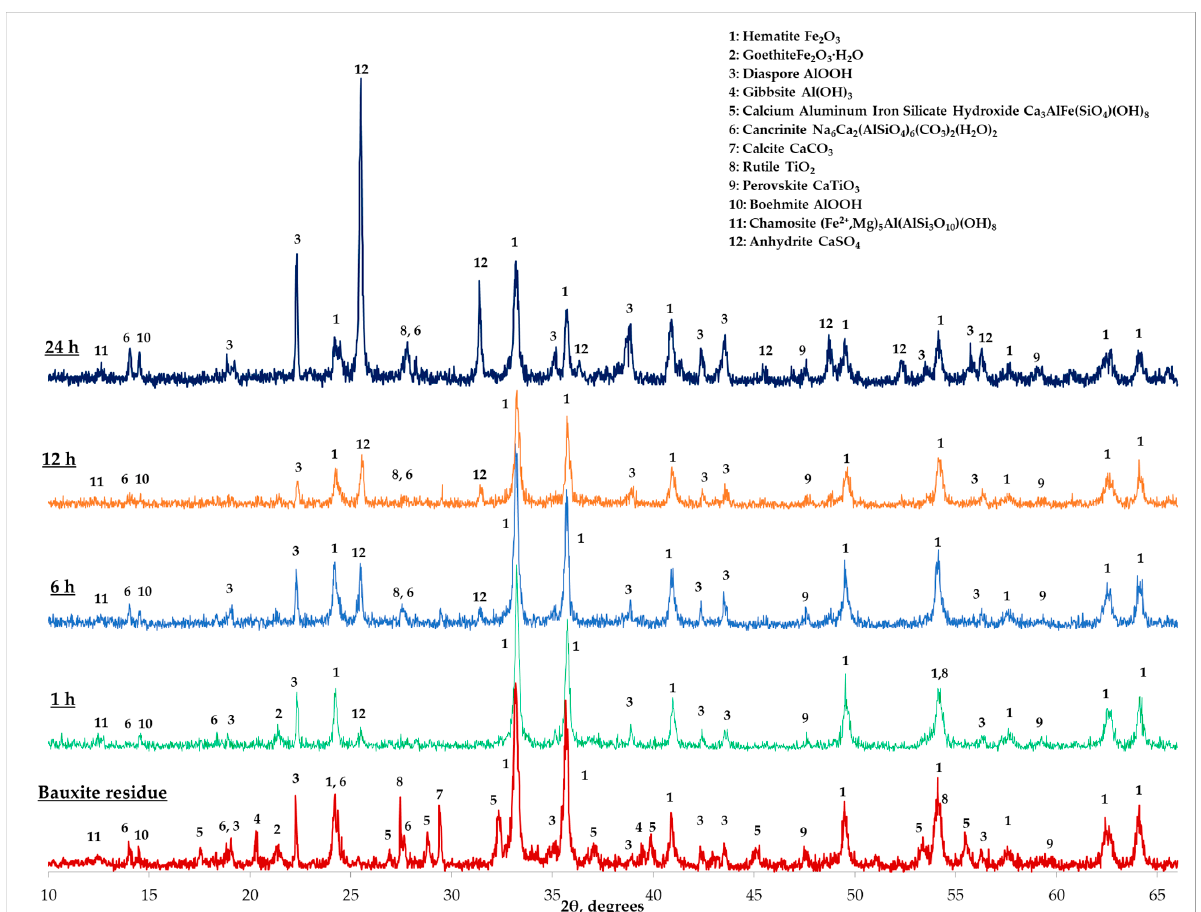
Figure A3. Comparison between X-ray powder diffractometer (XRD) of bauxite residue and solid residue after leaching bauxite residue at 150 °C, 200 rpm, 5% w / v pulp density for 1, 6, 12, and 24 h.